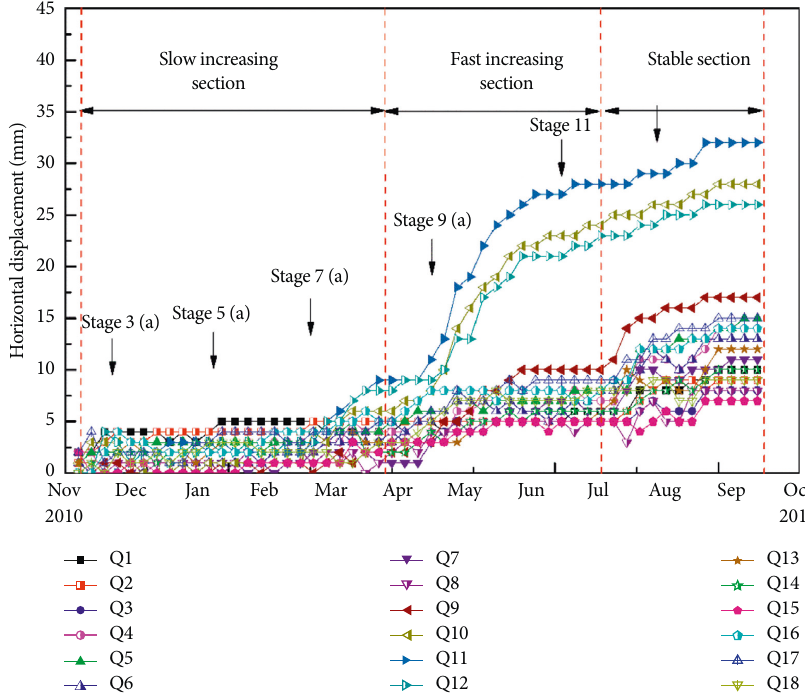
Figure 12: Horizontal displacement of top of wall during